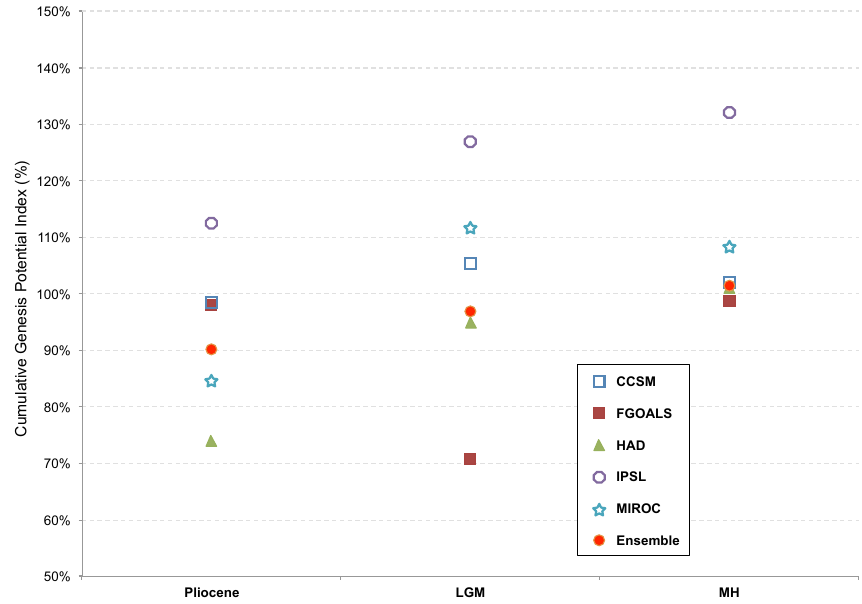
Figure 9. Model and ensemble mean cumulative annual global genesis potential index as percentage of preindustrial